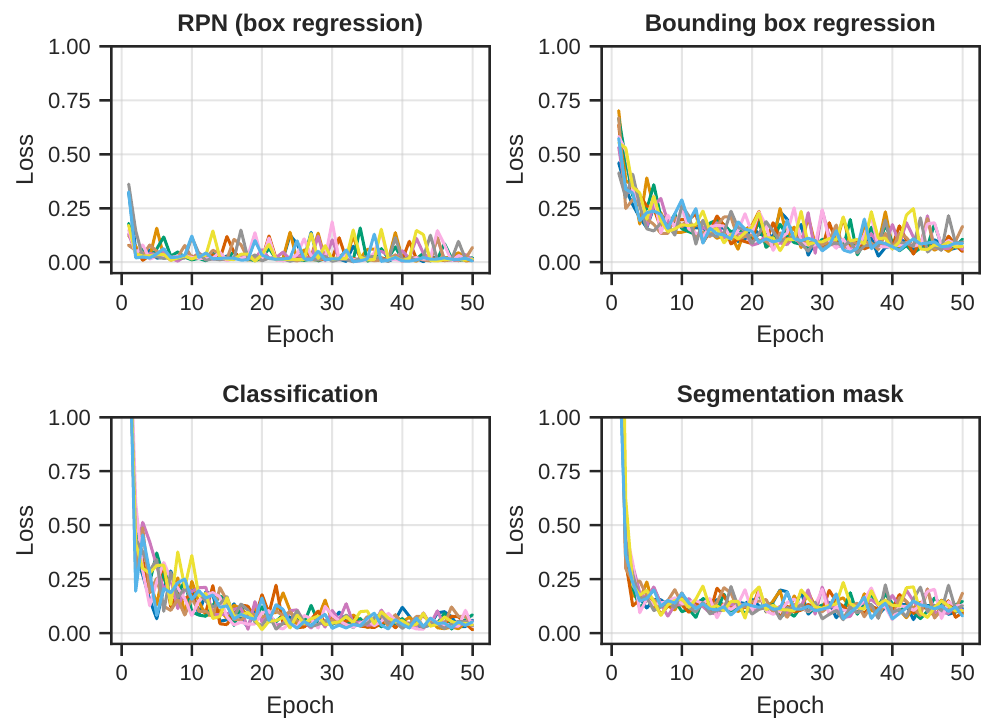
Figure 5. Evolution of the individual loss terms for each of the 10 training runs. ( Top left ): The loss term for the RPN box regression sub-task. Fairly rapid convergence, but we can see the effect of the single-image batches in the curves. ( Top right ): Bounding box regression loss for the detection branch. The convergence is slower when compared to the RPN loss, and perhaps slightly less stable. ( Bottom left ): Object classification loss for the detection branch. A similar story can be seen here as with the bounding box regression, which suggests a possible challenge with the detection branch. ( Bottom right ): The segmentation mask loss for the segmentation branch. Fast convergence, but, again, we see the effect of the single-image training